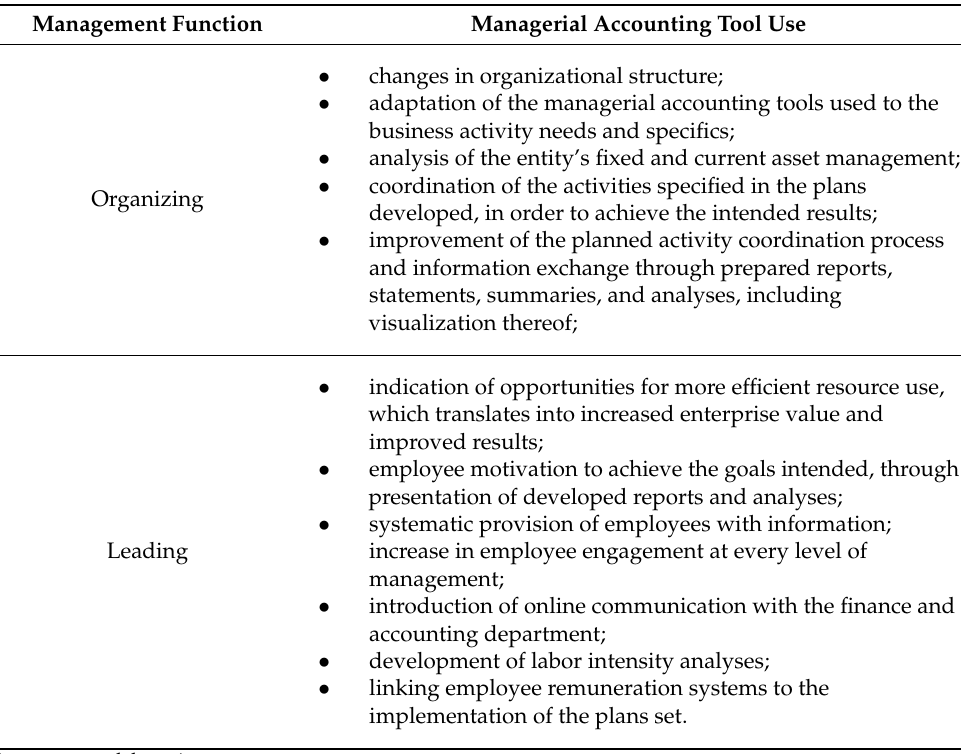
Table 7. Application of managerial accounting tools in energy entity